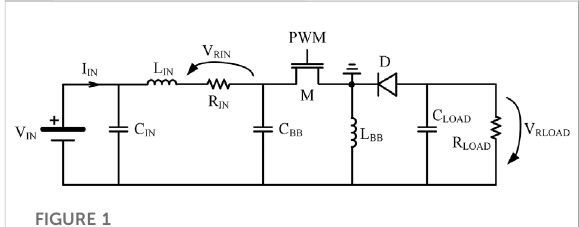
FIGURE 1 Active Load circuit topology.